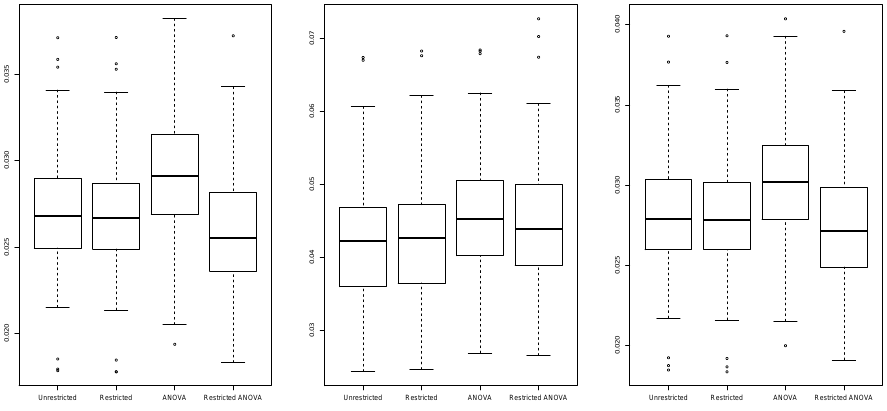
Figure 9. MAE in the fit ( left ), in the forecast ( middle ) and in total ( right ) of smooth models in = 0 and n x = scenario 1 and n z p p